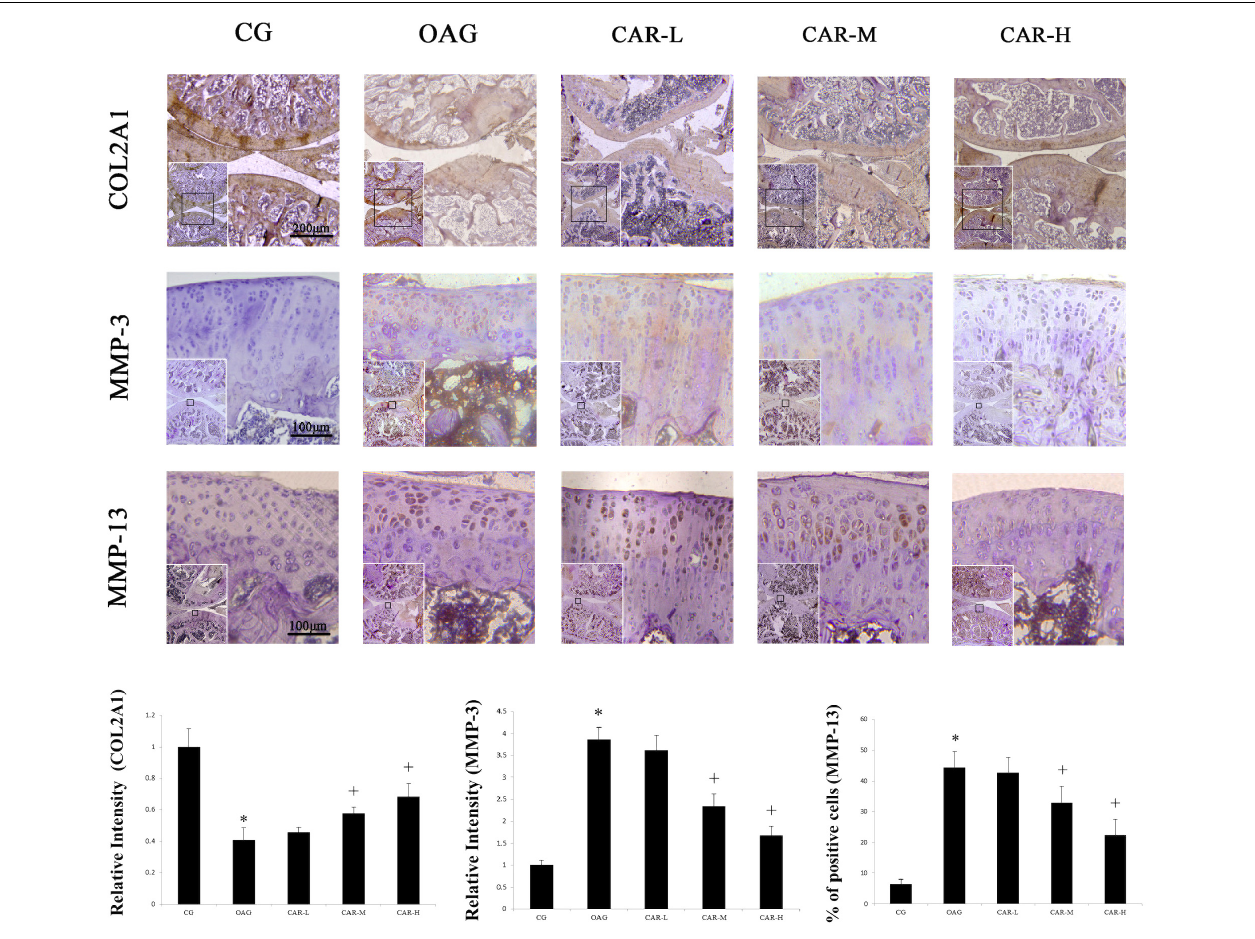
FIGURE 4 | Immunohistochemical staining. The micrographs show the relative intensity of immunohistochemical staining for COL2A1 and MMP-3, and the percentages of MMP-13 positively stained cells in the articular cartilage of each experimental group. Differences between the CG and OAG were significant ( ∗ P < 0.001), and differences between the OAG vs. CAR-M and CAR-H were significant ( + P < 0.001). One-way ANOVA, n = 5 rats for each group, mean score with 95% confidence intervals.